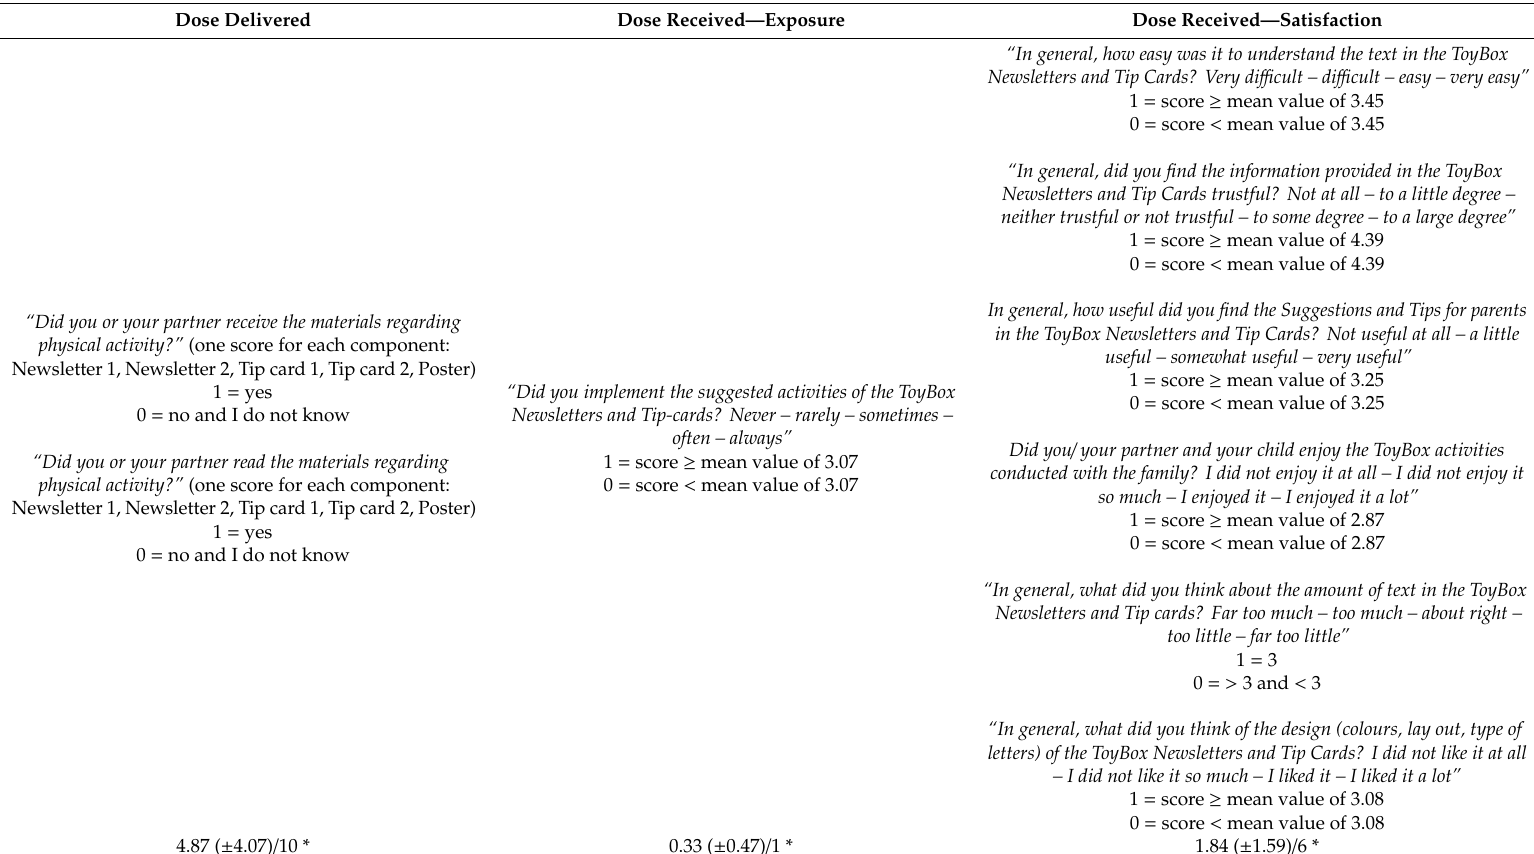
Table 2. Overview process evaluation questions to calculate the process evaluation score (score on 17) for